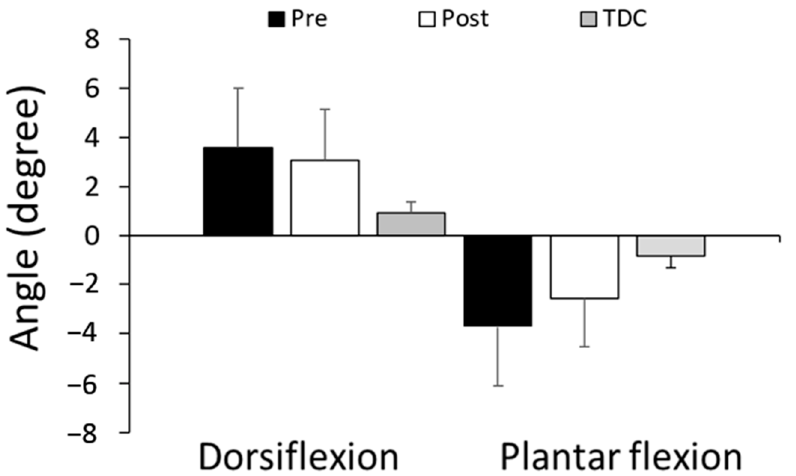
Figure 3. Proprioceptive acuity in dorsiflexion and plantar flexion. Proprioceptive acuity was measured as the threshold angle in plantar or dorsiflexion movement (at the speed of 0.5 ◦ /s operated by the ankle rehabilitation robot) at which the participant recognized the movement.